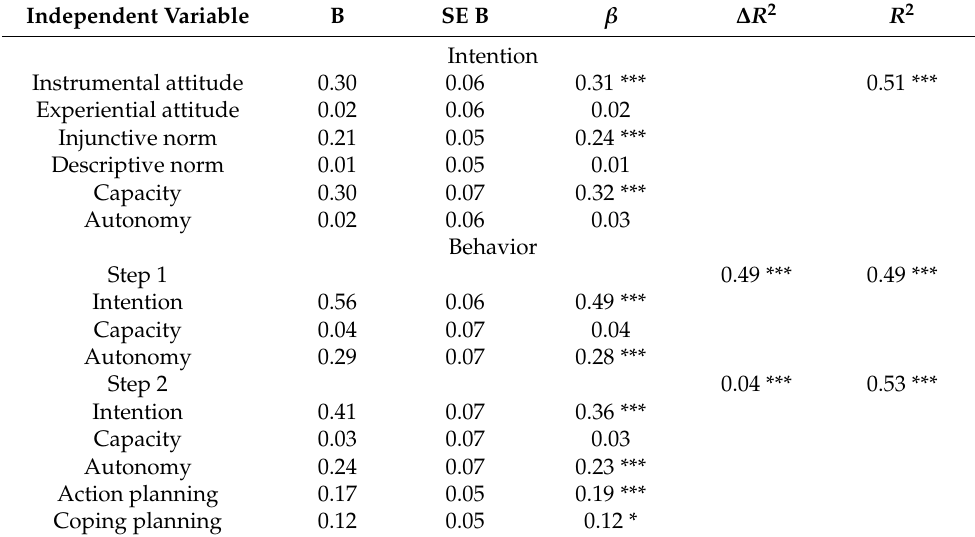
Table 3. Regression analyses predicting diet intention (N = 273) and behavior (N =